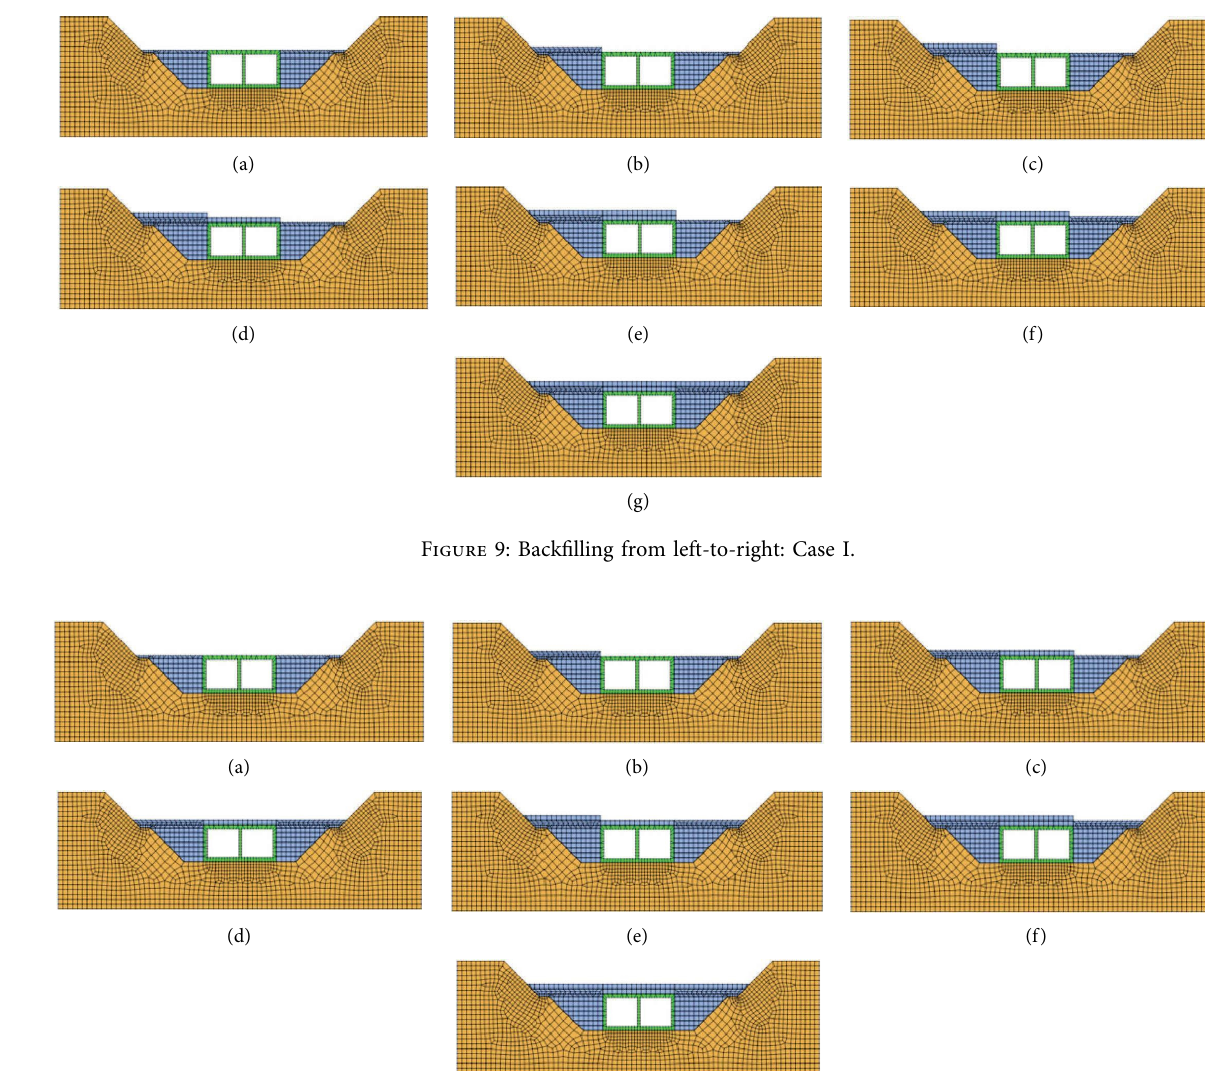
Figure 8: Bilateral backflling in region 1.